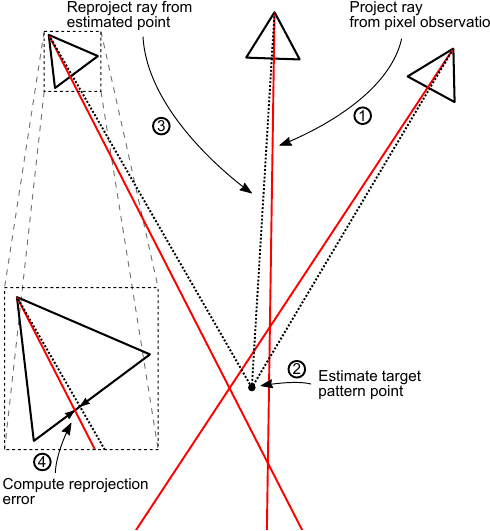
Figure 2. Method summary. Rays corresponding to individual calibration pattern point observations are determined from pixel observations and camera poses. Calibration pattern point locations are then triangulated from all rays, and subsequently reprojected to the camera sensor. A reprojection error can then be computed by calculating the difference between the reprojected point and the pixel